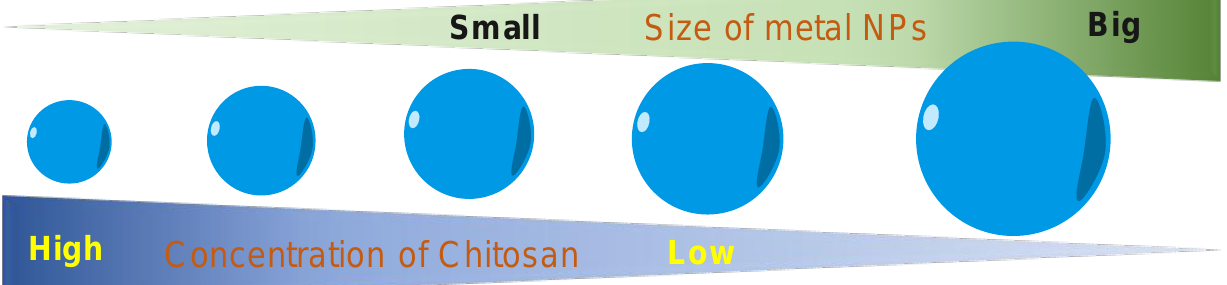
Figure 4. The correlation of concentration of chitosan and the size of metal nanoparticles.